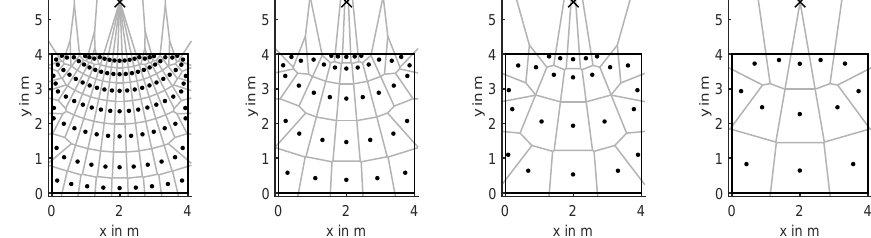
Figure 4. Examples of nonuniform grids for a quadratic room and frontal sound source (x); f.l.t.r.: Grid 1 α = 5 ◦ , d = 0.25; Grid 2 α = 10 ◦ , d = 0.5; Grid 3 α = 15 ◦ ; d = 0.75; and Grid 4 α = 20 ◦ , d =